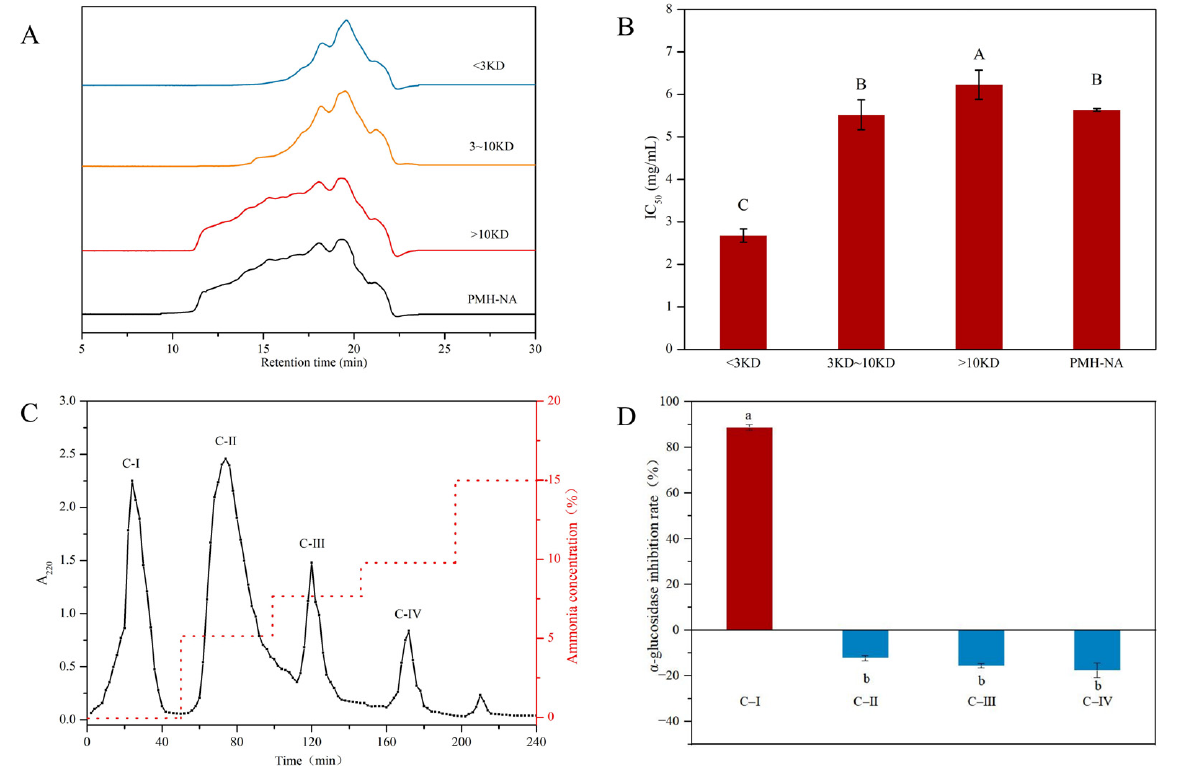
Figure 2. ( A ) SEC-HPLC profiles of fractions after ultrafiltration. ( B ) IC 50 value of each fraction after ultrafiltration. ( C ) Elution spectra of <3 kDa components on cation exchange column. ( D ) α -glucosidase inhibition rate of fractions separated by cation exchange column. Different letters indicate significant differences ( p < 0.05).